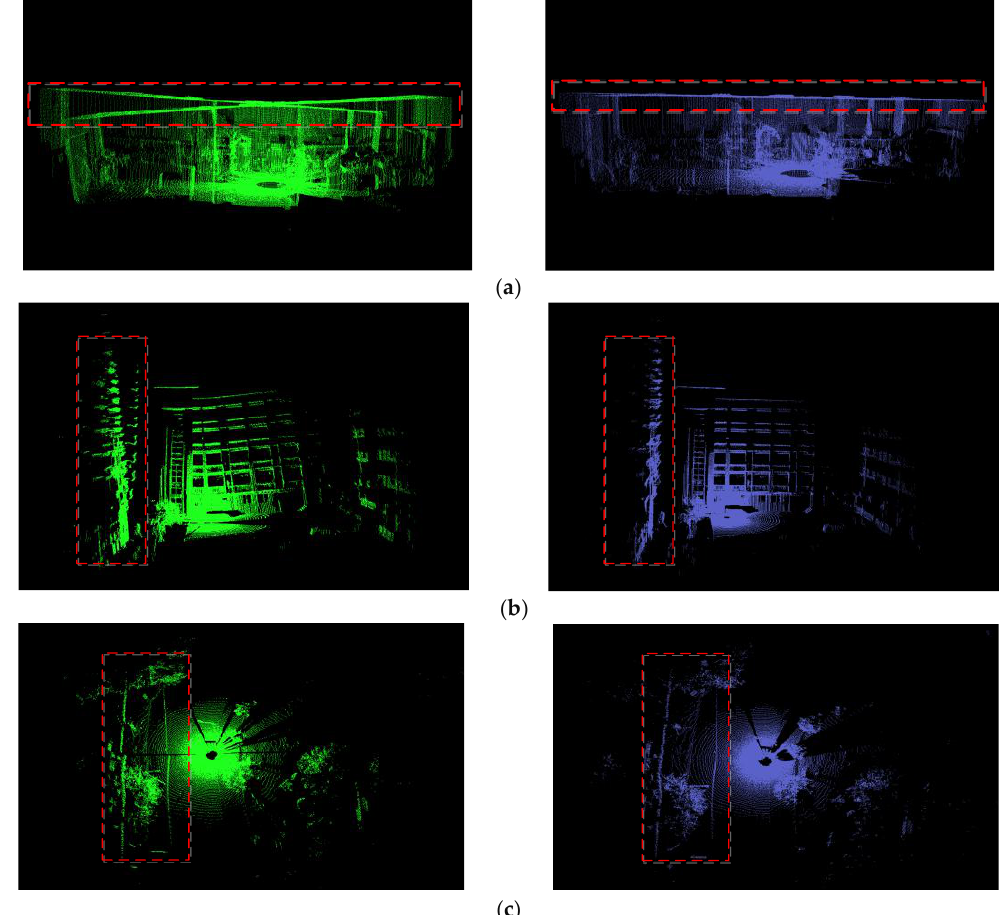
Figure 9. 3D point clouds captured by the R2D-LIDAR system in three typical scenarios, i.e., room, construction and roadway. The left plots present the uncalibrated point clouds, and the right plots represent the point clouds captured with bias adjustment. The differences between the left plots and the right plots highlighted by red box: ( a ) the great bias of the roof on the left was eliminated after calibrating and some bumps on the right were the lamp holders on the roof; ( b ) the construction on the left was obviously an inclination, which was rectified through our adjustment; ( c ) the roadway existed crack on the left and it became continuous after adjustment.